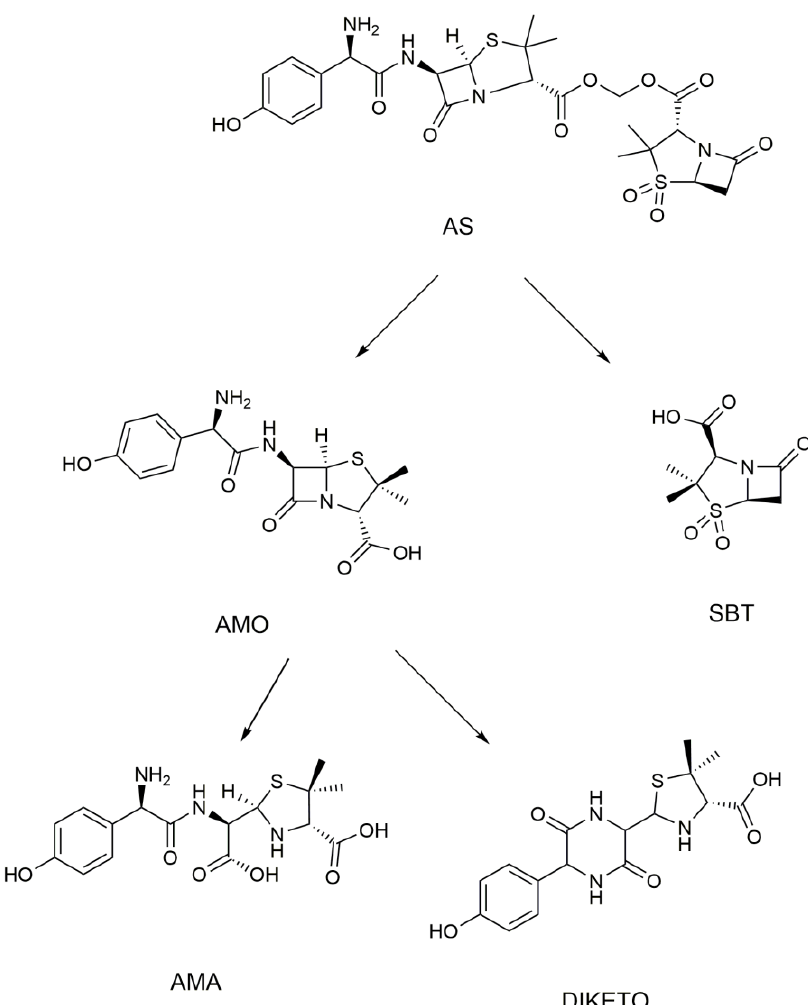
Figure 2. Metabolite-prediction diagram for AS.